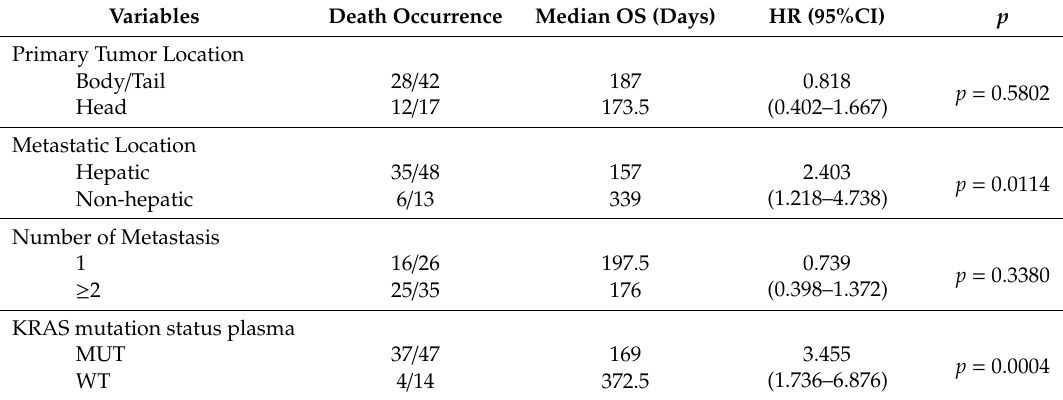
Table 2. Overall survival